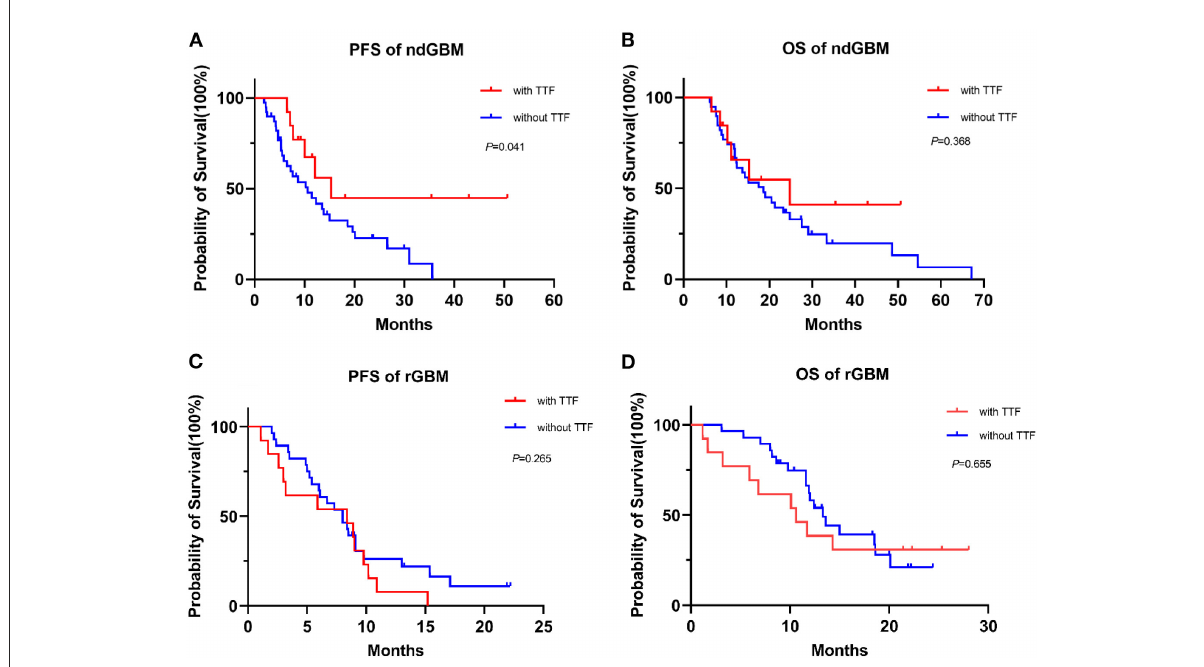
FIGURE1 The survival analysis of the newly diagnosed glioblastoma (ndGBM) and recurrent GBM (rGBM) in two groups. (A) Progression-free survival (PFS) of ndGBM; (B) overall survival (OS) of ndGBM; (C) PFS of rGBM; (D) OS of